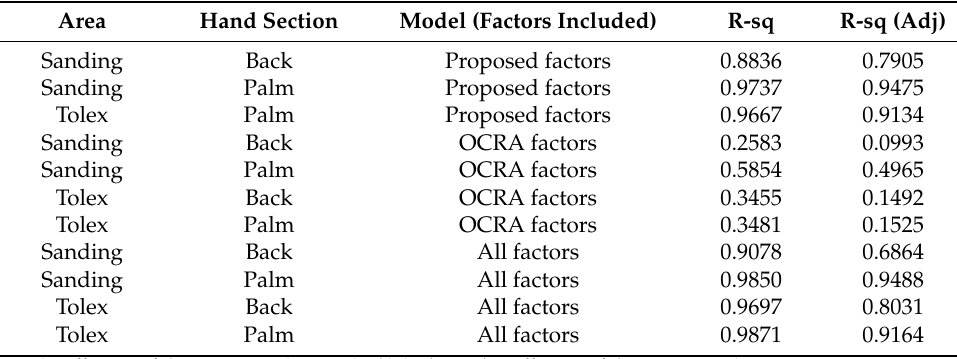
Table 8. Mixed-design analysis of variance of the study factors for the sanding area. Area-Section Factor p -Value Sanding-Back